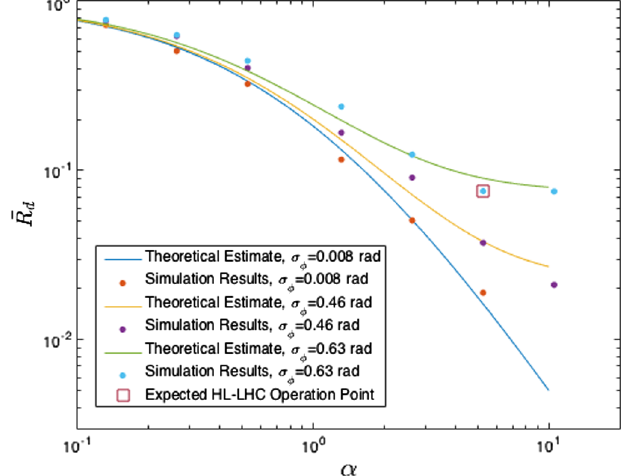
FIG. 17. Growth rate dependence on bunch length C Δ amplitude noise.